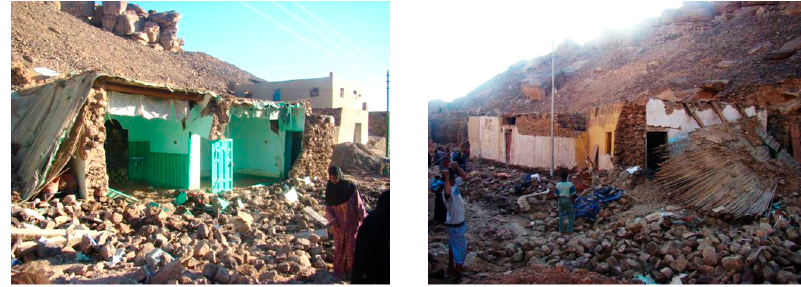
Figure 1. Buildings are destroyed in Abouelreesh village after a torrent of floodwater in 2010.